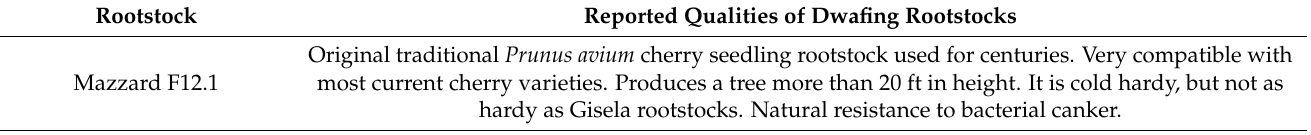
Table 2. Some of the most commonly used Cherry rootstocks for commercially cultivated sweet